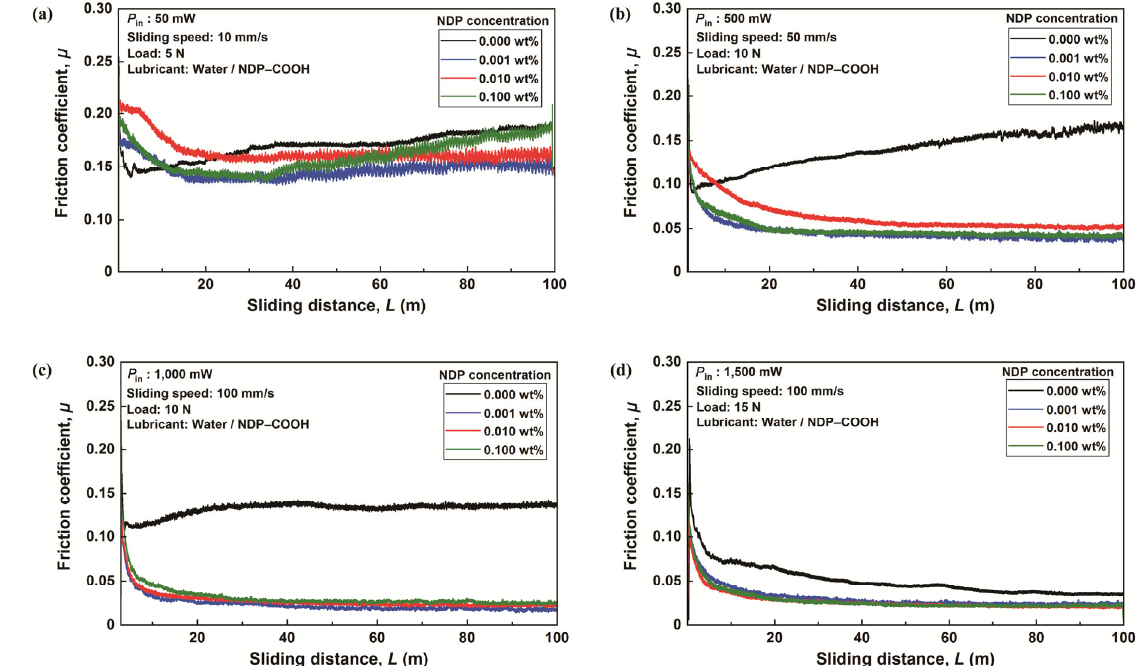
Fig. 11 Friction properties in 100 m-sliding. Four lubricant-dispersed NDPs of different concentrations (0 (pure water), 0.001 wt%, 0.01 wt%, and 0.1 wt%) under four experimental driving conditions are discussed: (a) 5 N and 10 mm/s ( (b) 10 N and 50 mm/s ( P = 500 mW); (c) 10 N and 100 mm/s ( in